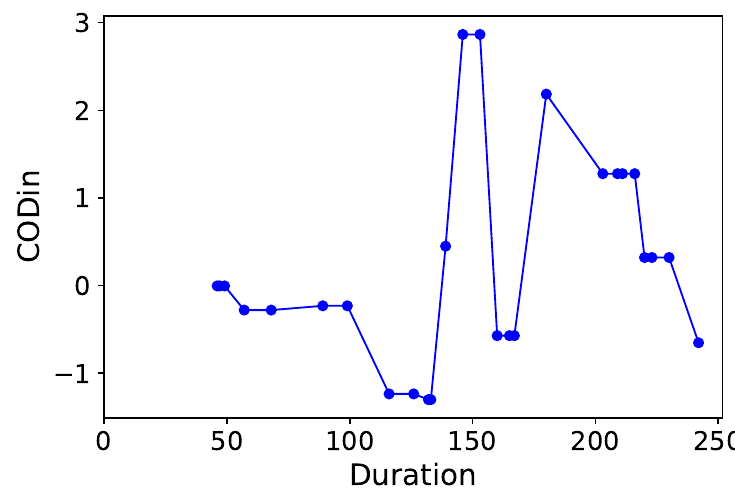
Figure A12. Normalized chemical oxygen demand for Reactor 1.